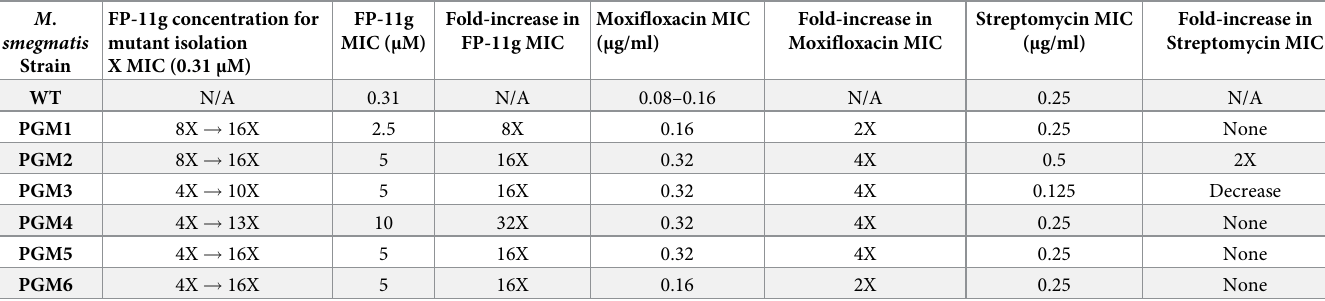
Table 1. FP-11g resistant mutants, resistance levels and cross-resistance to Moxifloxacin. FP-11g concentration for M . mutant isolation smegmatis Strain X MIC (0.31 μ